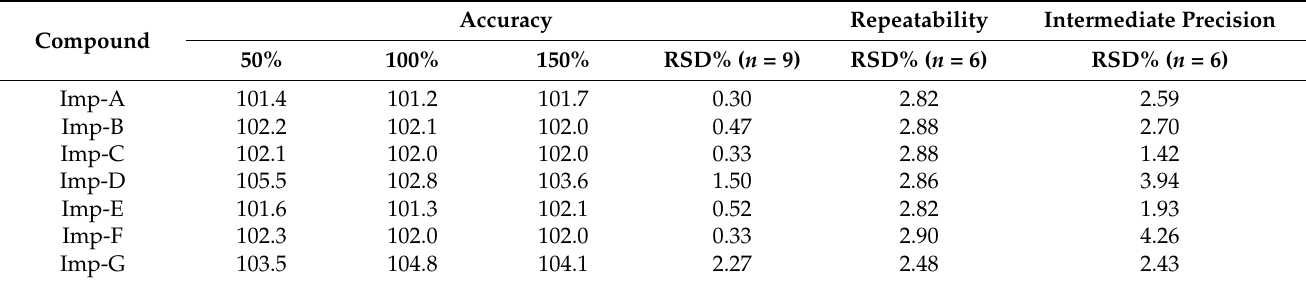
Table 5. Results for accuracy, repeatability, and intermediate precision studies of impurity